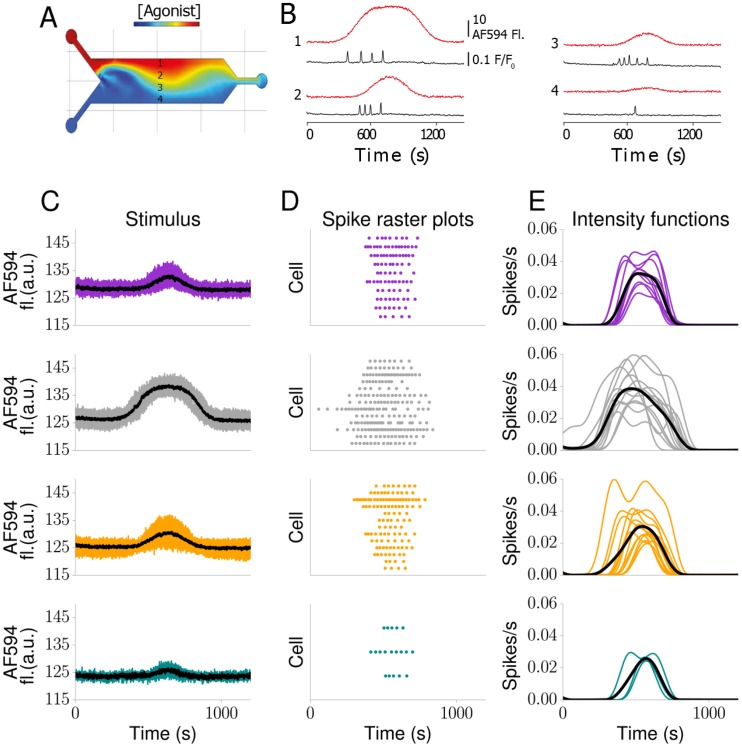
Dynamically stimulated HEK293T cells.(A) Simulation of complex concentration surface generated inside the microfluidics chamber after transiently varying relative flow rates of agonist and buffer input streams (COMSOL Multiphysics, COMSOL Ltd, Cambridge, UK). (B) Agonist concentration (indicated by AF594 fluorescence; red lines) and normalised Fluo-5F fluorescence intensity traces (black lines) from ROIs centred on 4 cells across the width of the channel upon applying a single sine-wave stimulation regime. Stimulus fluorescence (C), raster plots (D) and GP Ca2+ spike rate estimations (E) for each cluster in Fig 8. Black lines denote the mean stimulus (C) and the mean Ca2+ spike rate (E) in each group, respectively.